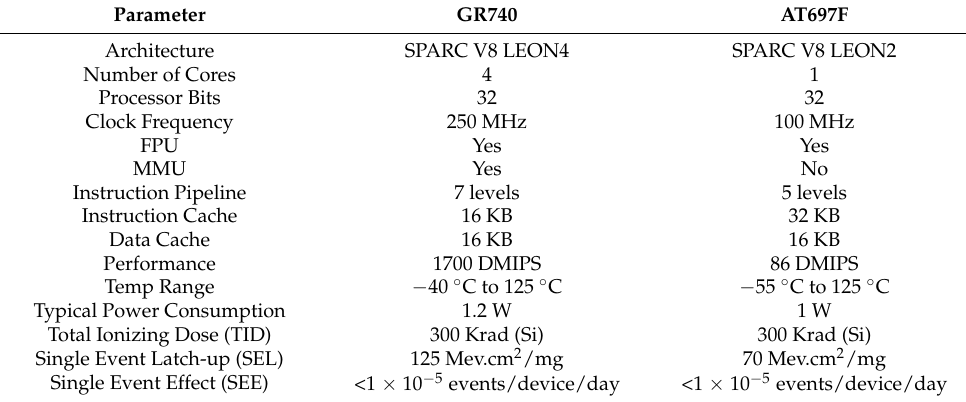
Table 1. Main parameters comparison between GR740 and